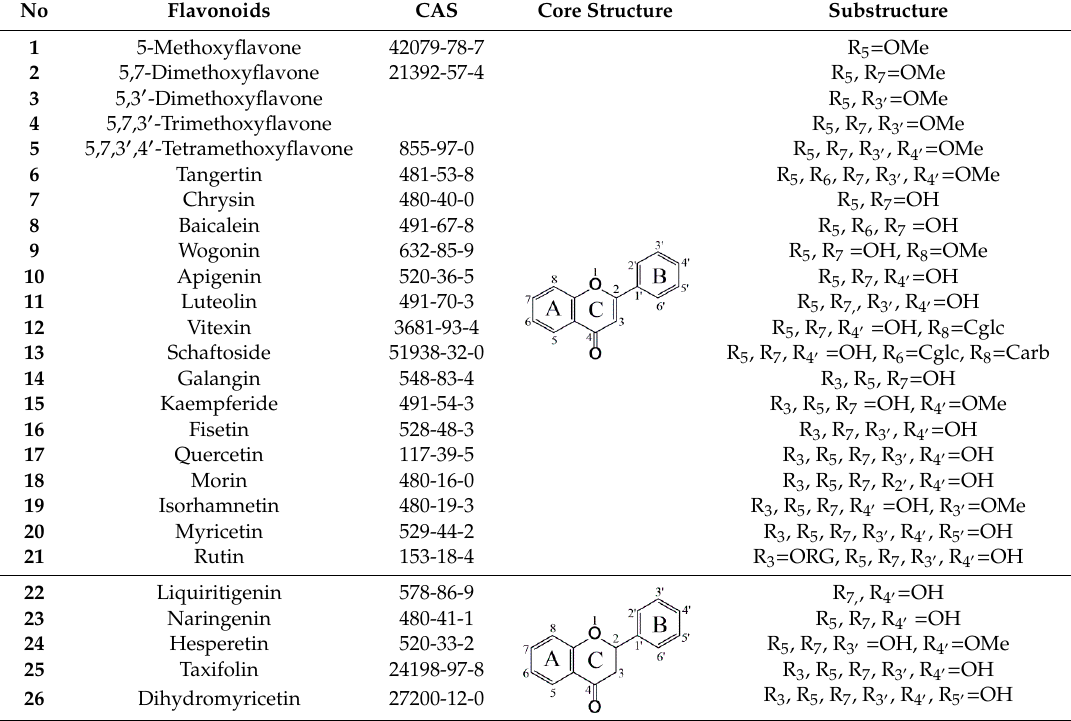
Table 1. The chemical structures of 31 flavonoids.